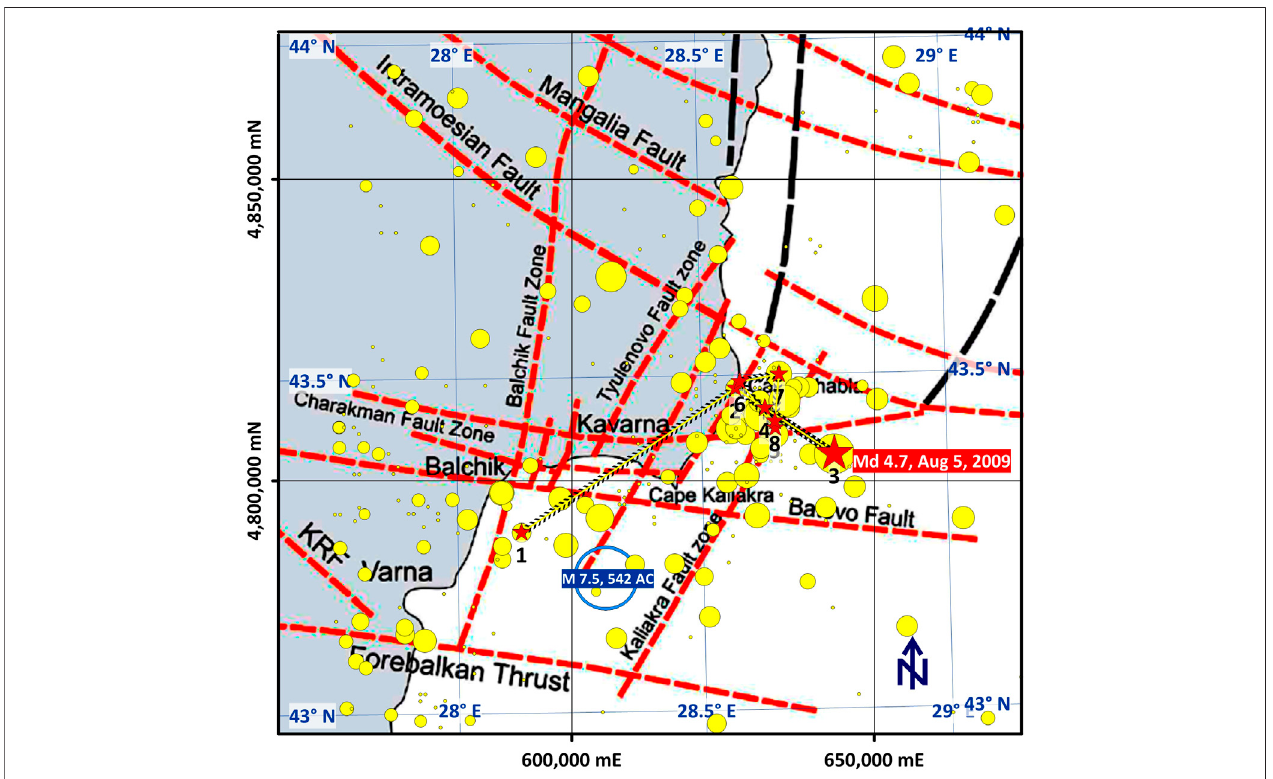
FIGURE 2 | The Shabla-Kaliakra-Balchik seismic region: main faults and registered earthquakes over the period 1986 – 2014 (after Oaie et al., 2016 and Tsekov etal.,2019).Yellowdotsrepresentearthquakeepicenters.Witharedstarisrepresentedthestrongestearthquakeintheregionovertheperiod1986 – 2014,occurringon 5 August, 2009, with Md 4.7. Numbers indicate this earthquake and its foreshocks and aftershocks in a chronological order.